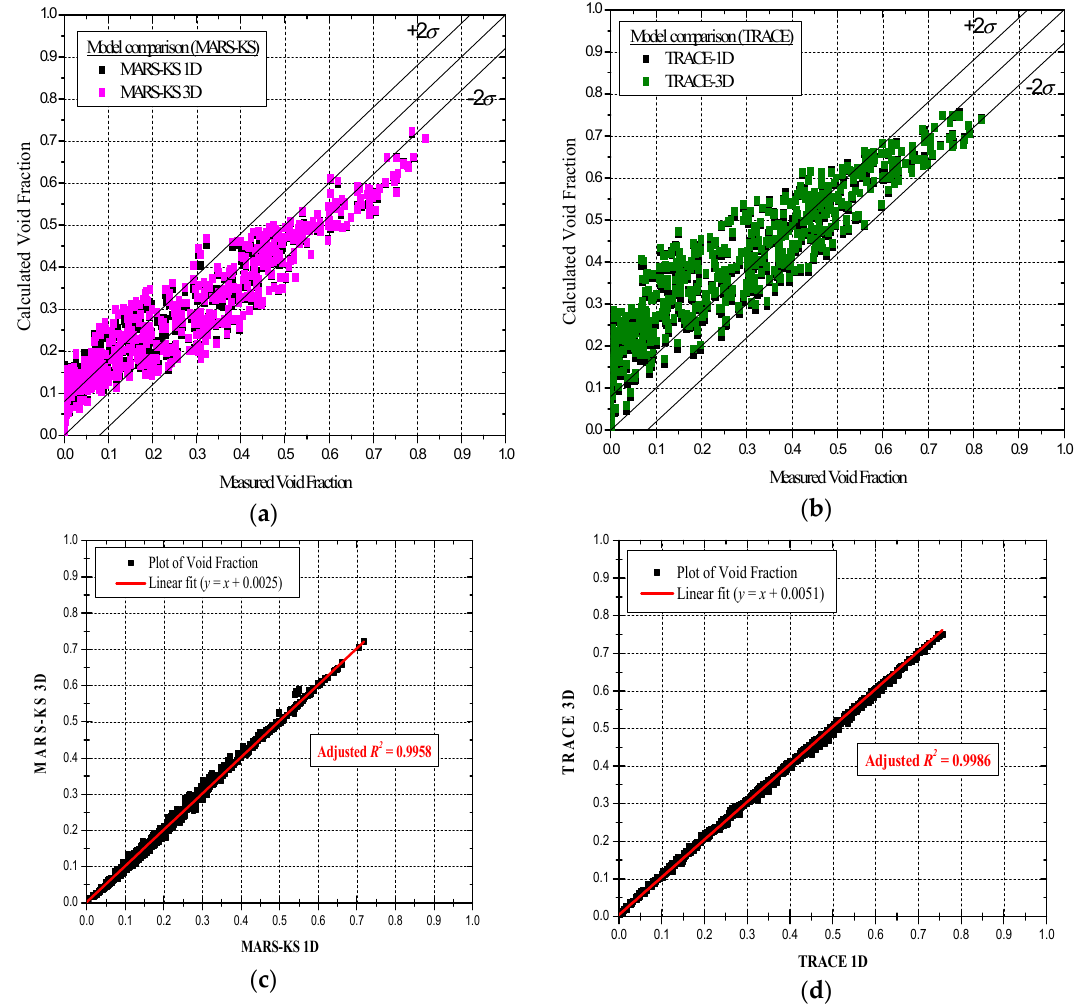
Figure 5. Model comparisons: ( a ) Calculation results of MARS-KS against experimental data; ( b ) calculation results of TRACE against experimental data; ( c ) linear fit of the 3D model of MARS-KS against the 1D model of itself; ( d ) linear fit of the 3D model of TRACE against the 1D model of itself.